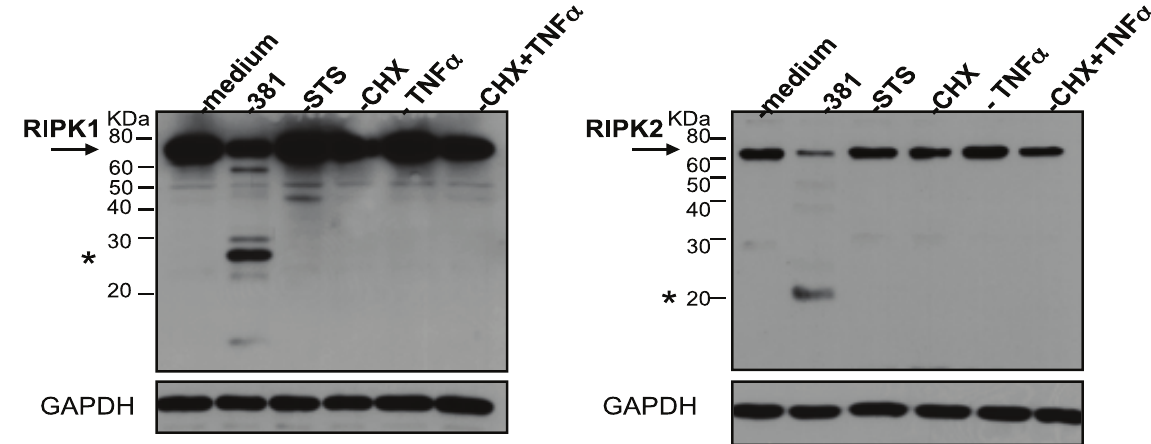
Figure 4. Classical apoptotic stimuli do not induce the proteolysis of RIPK1 or RIPK2 in HUVEC. HUVEC were treated with medium, P. gingivalis 381 (MOI 100), 2 m M staurosporine ( STS ) 25 m g/ml cycloheximide ( CHX ), 10 ng/ml TNF a , or co-treated with 25 m g/ml CHX and 10 ng/ml TNF a for 6 h. Whole cell lysates were analyzed for the detection of RIPK1 (left panel) or RIPK2 (right panel). Full-length RIPK1 and RIPK2 are indicated with arrows. Prominent P. gingivalis -induced LMW bands are indicated with asterisks. MW ladder is indicated on the left in kDa. GAPDH was detected as a loading control. ( Figure 9B ) levels and induced the detection of LMW